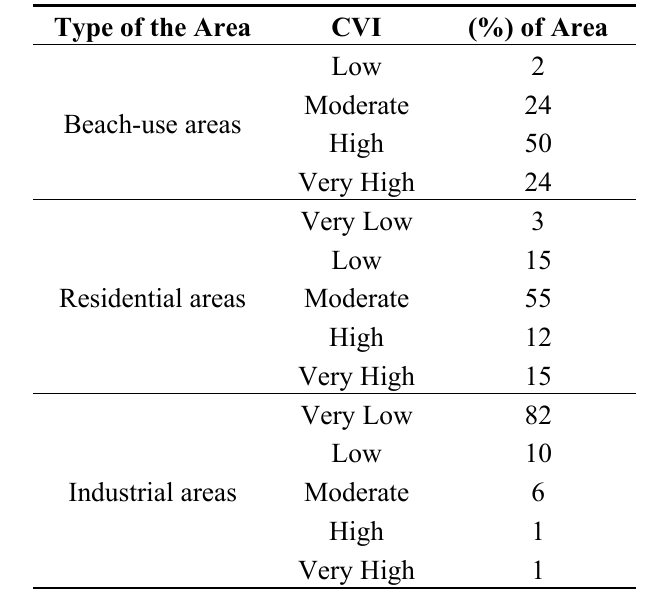
Figure 16. Composite Vulnerability Index (CVI): ( a ) Cabedelo; ( b ) Cova Gala; ( c ) City of Setúbal; ( d ) Outão; ( e ) Industrial zone; and ( f ) Martinhal. Table 7. Percentage of area by CVI vulnerability